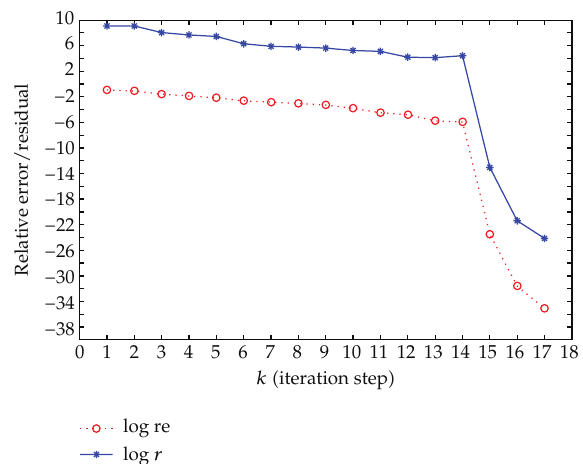
Figure 1: The relative error of the solution and the residual for Example 4.1 with X 1 / (cid:2) 0